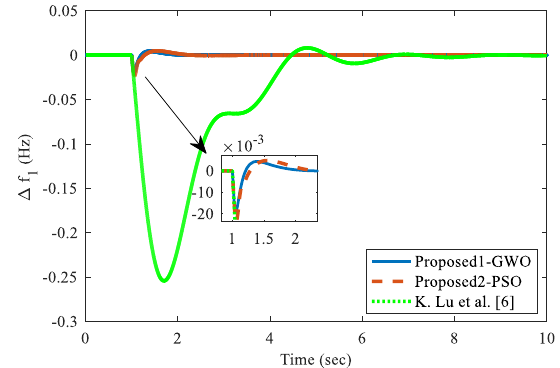
Fig. 10 Frequency regulation in area 1 for case 5a